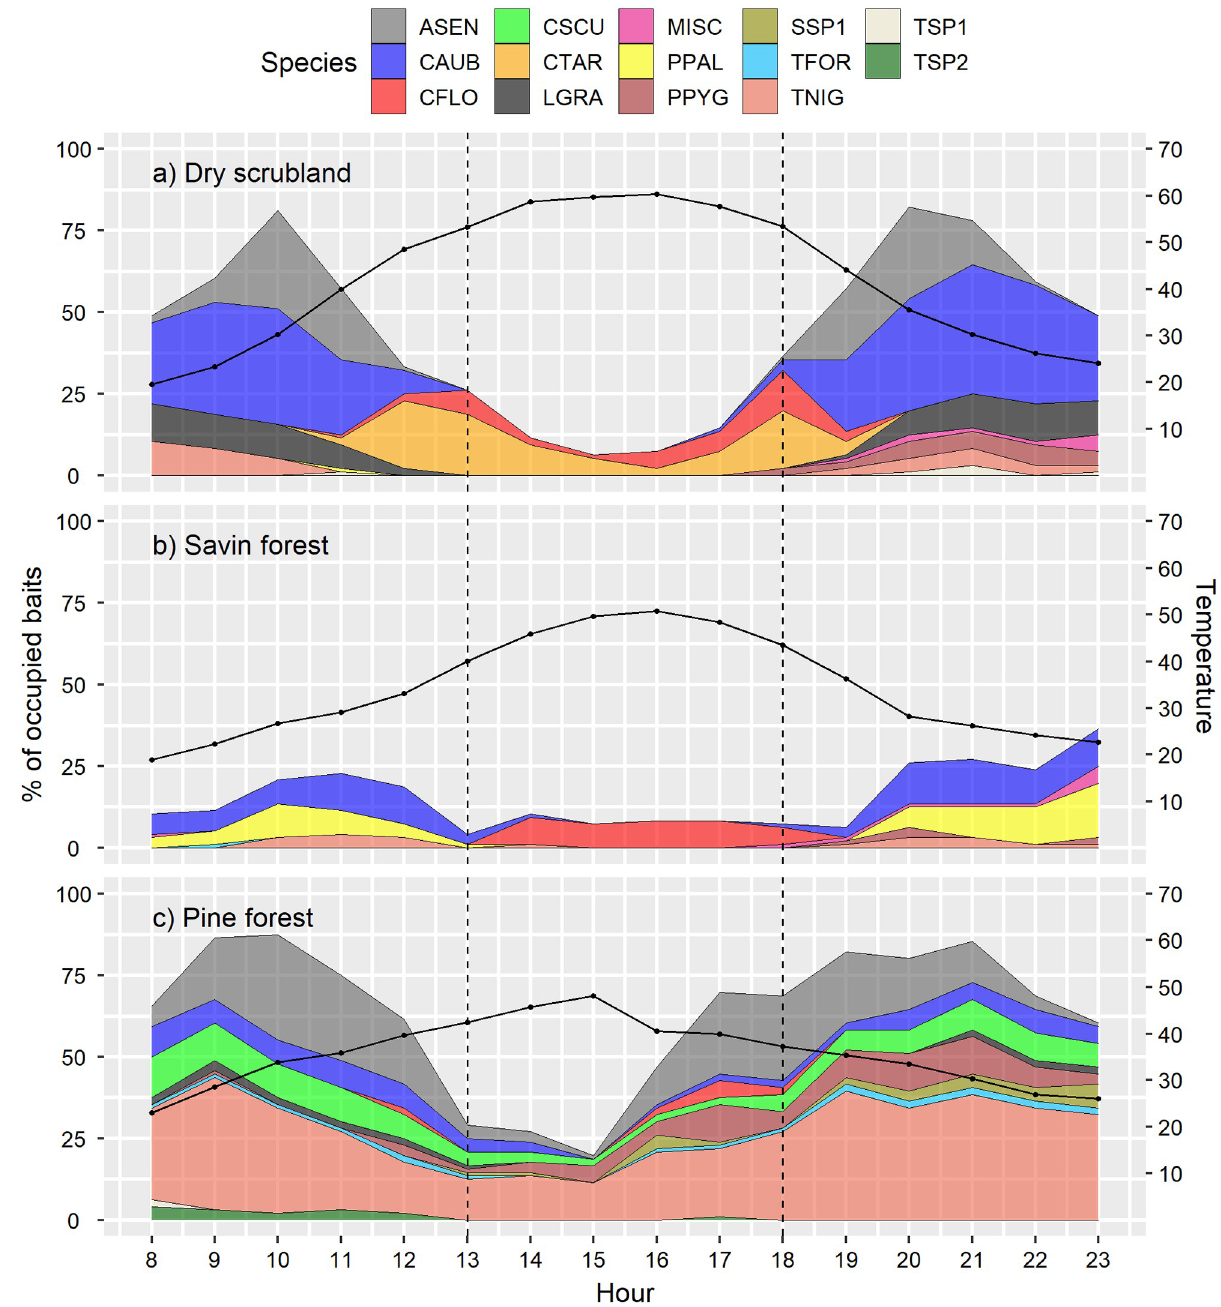
Fig 3. Bait occupation by hour in each habitat: (a) Dry scrubland, (b) Savin forest, and (c) Pine forest. Mean temperature for each habitat is shown with a black line and represented on the right axis. Dashed lines divide the hours in 3 periods: 8h to 13h and 18h to 23h –the coolest ones, and 13h to 18h – the warmest ones. Species abbreviations: ASEN ( Aphaenogaster senilis ), CAUB ( Crematogaster auberti ), CFLO ( Cataglyphis floricola ), CSCU ( Crematogaster scutellaris ), CTAR ( Cataglyphis tartessica ), LGRA ( Lasius grandis ), Miscellaneous (less abundant species), PPAL ( Pheidole pallidula ), PPYG ( Plagiolepis pygmaea ), SSP1 ( Solenopsis sp.), TFOR ( Tetramorium forte ), TNIG ( Tapinoma cf. nigerrimum ), TSP1 ( Temnothorax sp . 1) and TSP2 ( Temnothorax sp . 2).